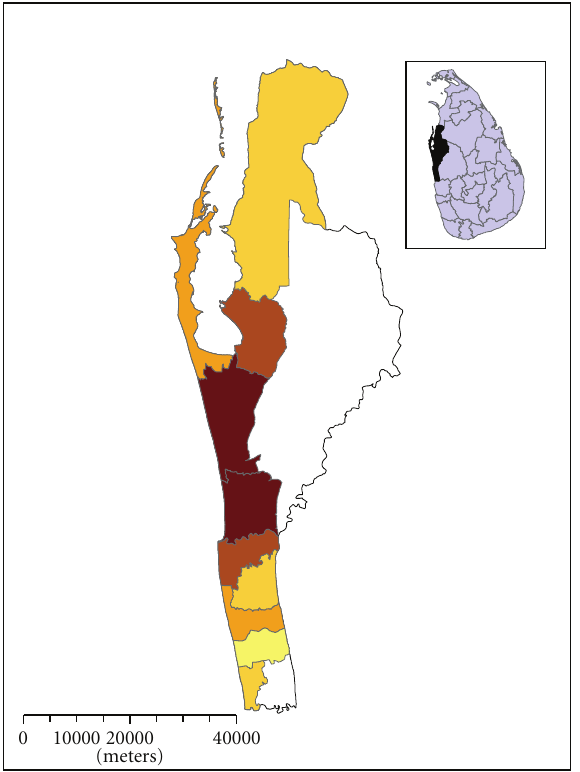
Figure 1: Shrimp farming zones of the Puttalam district, Sri Lanka. Shading reflects farm density with darker colours being higher density. Insert figure is a map of Sri Lanka which locates the Puttalam